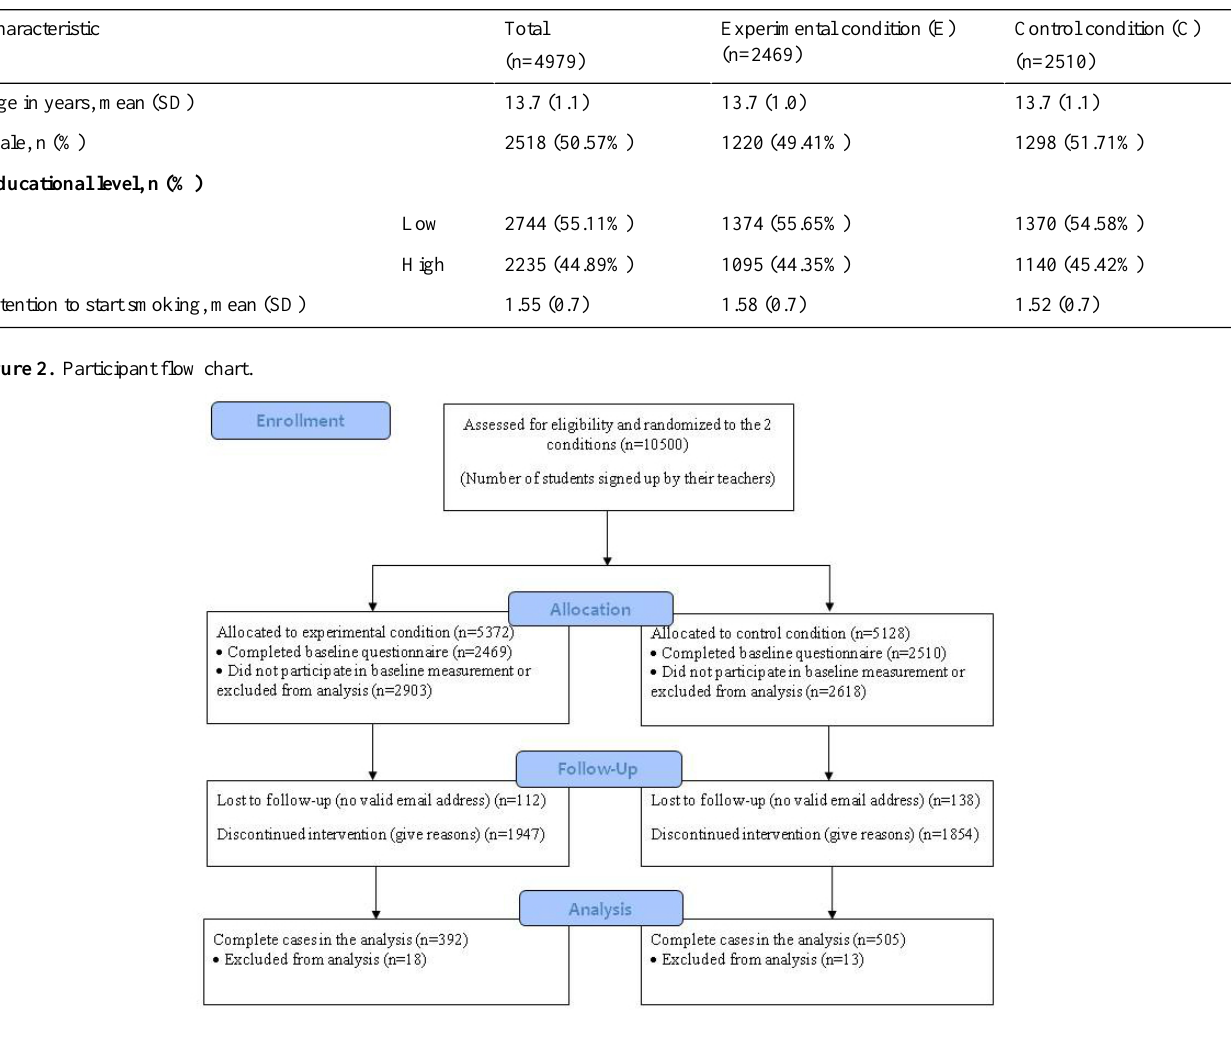
Table 2. Baseline sample characteristics of non-smoking adolescents (n=4979), recruited in 2011.